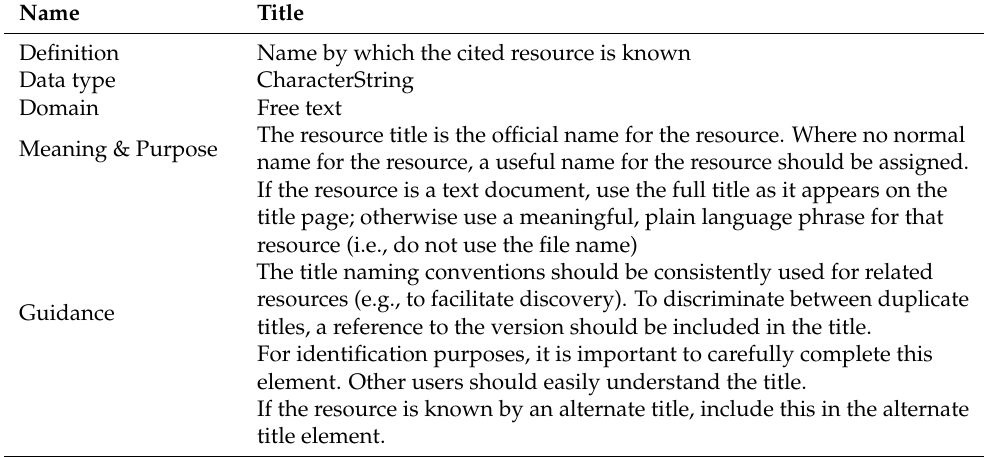
Table 18. Title description and guidance in the ANZLIC Metadata Profile Guidelines Version 1.2 [24].